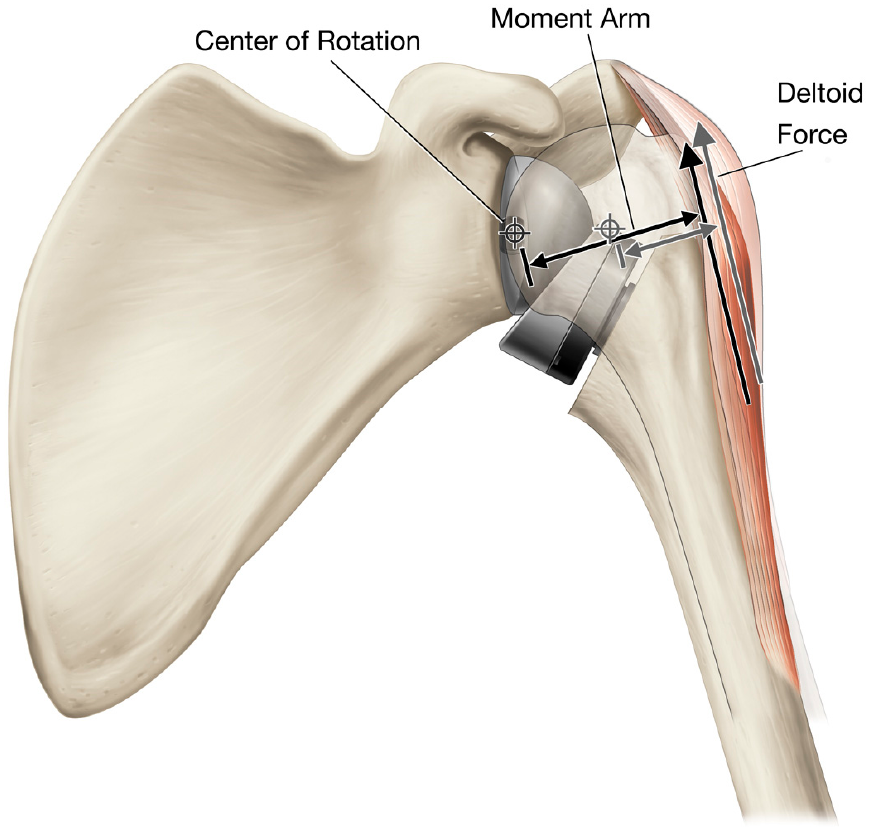
Figure 2. Increase in deltoid moment arm length with rTSA, relative to the native shoulder.